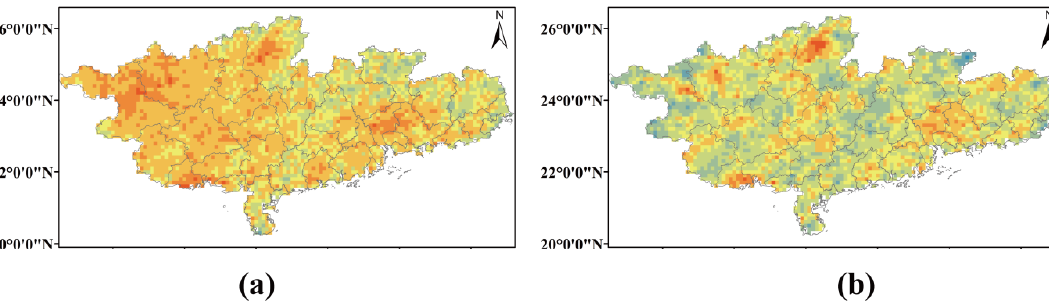
Figure 8. Spatial patterns in terms of root-mean-square error (RMSE) based on ( a ) PERSIANN-CCS, ( b ) ERA5-Land, ( c ) FY-4A, ( d ) GSMaP, and ( e ) IMERG against CMPA at hourly scale over southern China in summer 2019.